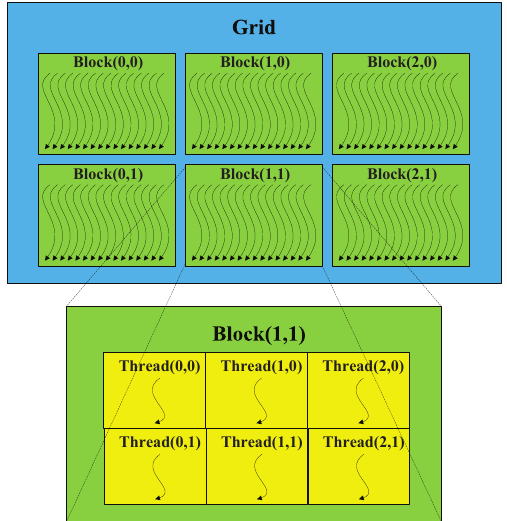
Figure 9. Multiple equally-shaped thread blocks.